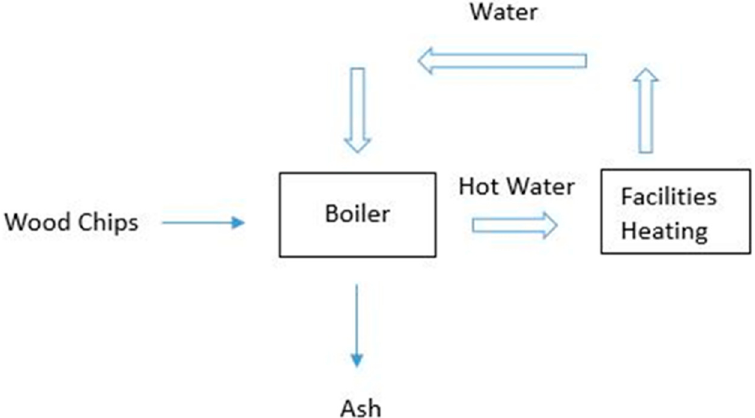
Figure 4. Schematic diagram for institutional heating.